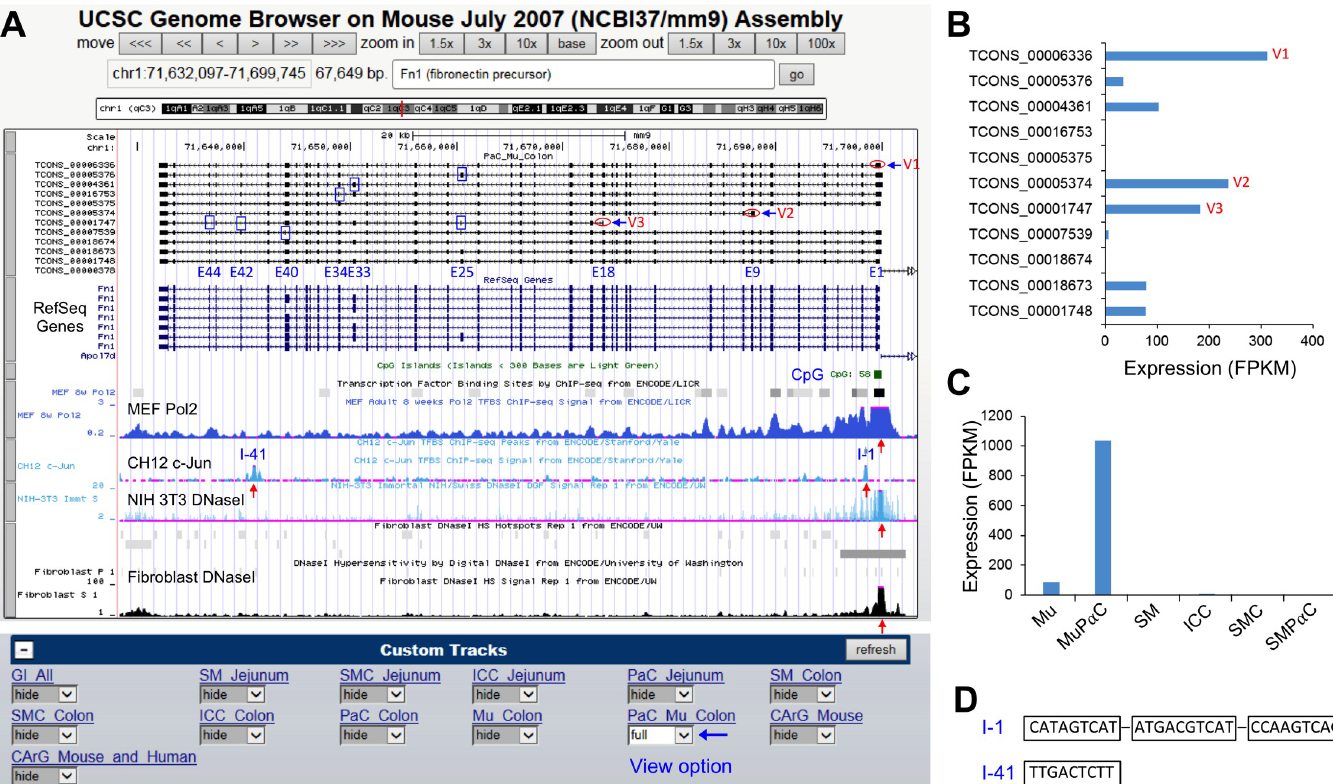
Fig 9. Genomic structure and expression data of Fn1 analyzed using the UCSC Smooth Muscle Genome Browser. A : A genomic map view of Fn1 variants expressed in MuP α C. Three alternative initial exons (V1-3) are circled and six alternative exons are boxed in blue. A CpG island denoted by a green box. Red arrows indicate either binding sites of Polymerase 2 (Pol2) in mouse embryonic fibroblasts (MEF), a heterodimer of FOS and JUN (c-Jun) constituting transcription factor AP1 in CH12, or DNase I hypersensitive sites in NIH 3T3 and fibroblasts. Custom Tracks have view options (hide, dense, squish, pack, full: full is selected in the image) for the transcriptome data of MuP α C (eGFP + -PaC Mu Colon). B : Expression (FPKM) levels of Fn1 transcriptional variants in MuP α C whose structure is shown in A. The three most highly expressed variants (V1-3) are marked. C : Expression (FPKM) levels of total Fn1 mRNAs in colonic Mu, MuP α C, SM, ICC, SMC, and SMP α C. D : c-Fos and c- Jun binding DNA sequence within two peaks (I-1 and I-41) of c-Jun biding sites in A. Three binding sites of c-Fos and c-Jun binding, CATAGTCAT , ATGACGTCAT , and CCAAGTCAG are found at the peak of intron 1 (I-1) from PROMO while one binding site TTGACTCTT is found at intron 41 (I-41).